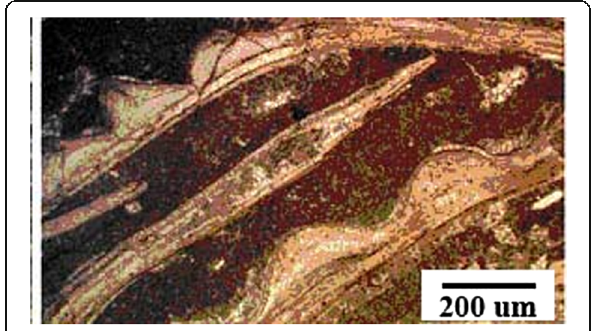
Fig. 9 Pelecypod biomicrite (wacke/packstone) microfacies showing a mega-sized pelecypod embedded in micritic matrix as well as a compaction effect, PPL